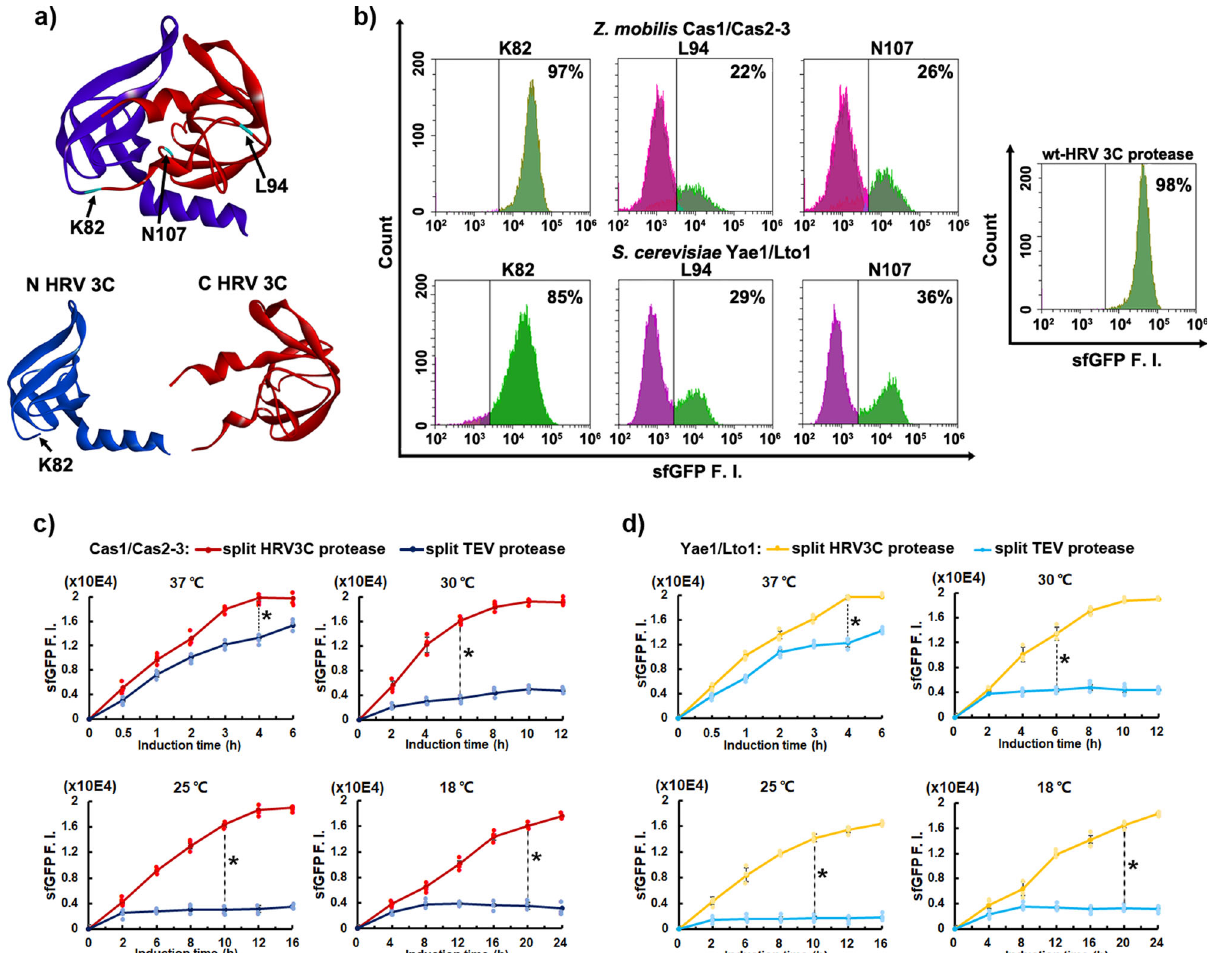
Fig. 2 Identi fi cation of a highly ef fi cient split HRV 3 C protease and its comparison with split TEV protease in the SPEC system. a Designing split HRV 3 C protease based on its structure (PDB: 2B0F) with three split positions (K82, L94, N107). Blue: N-terminal HRV 3 C protease, Red: C-terminal HRV 3 C protease, Purple: the random coil between N-terminal and C-terminal HRV 3 C protease, Cyan: the designed split sites. b Characterizing different split HRV 3 C proteases in SPEC system using pSPEC-N107/L94/K82-PP and pSPEC-N107/L94/K82-EP vectors, respectively. Cells bearing pSPEC-VB vector containing full length HRV 3 C protease was used as a positive control (right panel), and cells bearing only pSPEC-VA vector was used as a negative control (Fig. 1b). The total cellular sfGFP F. I. of cells bearing different vectors (pSPEC-K82-EP to pSPEC-N107-PP, Supplementary Table 1) were quantitated through fl ow cytometry. Upper-left panel, representative fl ow cytometry histograms of the total cellular sfGFP F.I. of cells expressing different split HRV 3 C proteases fused with Z. mobilis Cas1/Cas2-3 protein pair. Lower-left panel, representative fl ow cytometry histograms of the total cellular sfGFP F.I. of cells expressing different split HRV 3 C proteases fused with S. cerevisiae Yae1/Lto1 protein pair. The experiments were performed at 25 °C with 8 h induction. c Comparison of split HRV 3 C (K82) protease (Wine line, pSPEC-VC1) with split TEV protease (Dark blue line, pSPEC-VC5) using Cas1/Cas2-3 protein pair in SPEC system at 37 °C, 30 °C, 25 °C, and 18 °C, respectively. d Comparison of split HRV 3 C (K82) protease (Yellow line, pSPEC-VC2) with split TEV protease (Cyan line, pSPEC-VC6) using Yae1/Lto1 protein pair in SPEC system at 37 °C, 30 °C, 25 °C, and 18 °C, respectively. All the vector information can be found in Supplementary Table 1. Data are presented as mean ± SEM ( n = 3 independent experiments) with Student ’ s t test being performed, # P > 0.05, * P ≤